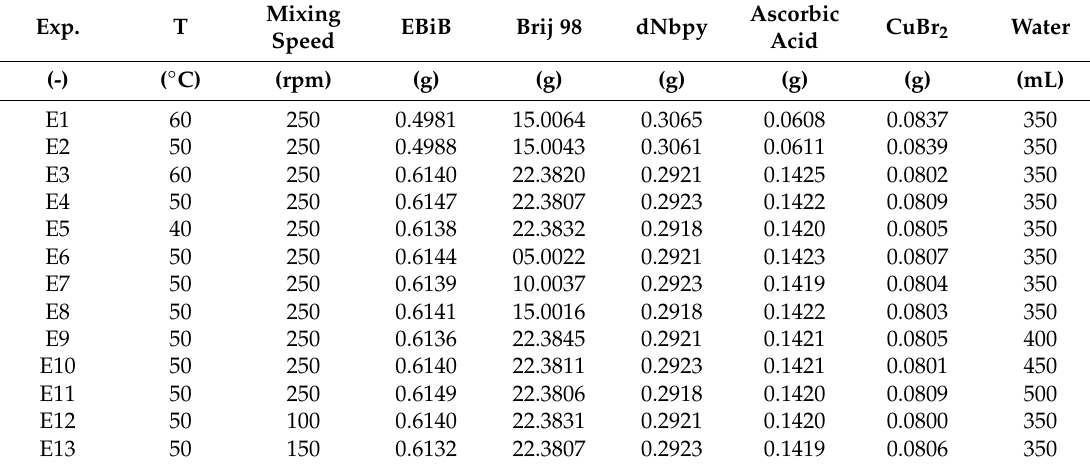
Experimental conditions of the emulsion activators generated by electron transfer (AGET) atom transfer radical polymerization (ATRP) of methyl methacrylate (MMA) using the 4,4 (cid:48) -Dinonyl-2,2 (cid:48) -dipyridyl (dNbpy) ligand.